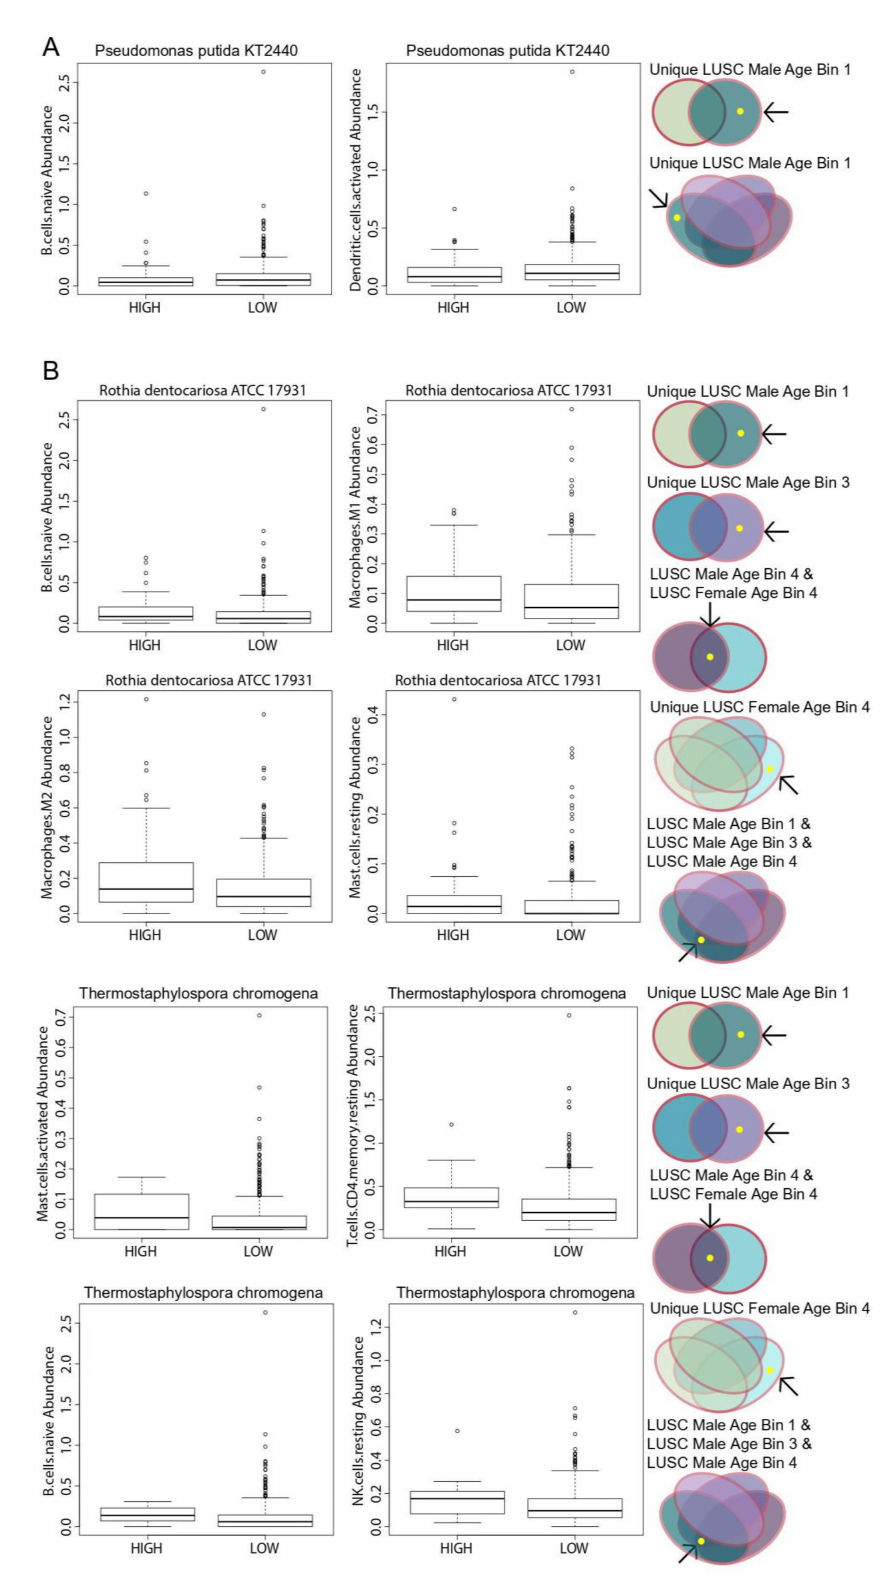
Figure 5. Correlation of di ff erentially abundant microbes in LUSC to immune cell populations. Boxplots showing that a higher expression of microbes correlates to ( A ) a lower abundance of immune cell populations and a ( B ) higher abundance of immune cell populations. The comparisons and cohorts that these microbes are associated with are shown to the